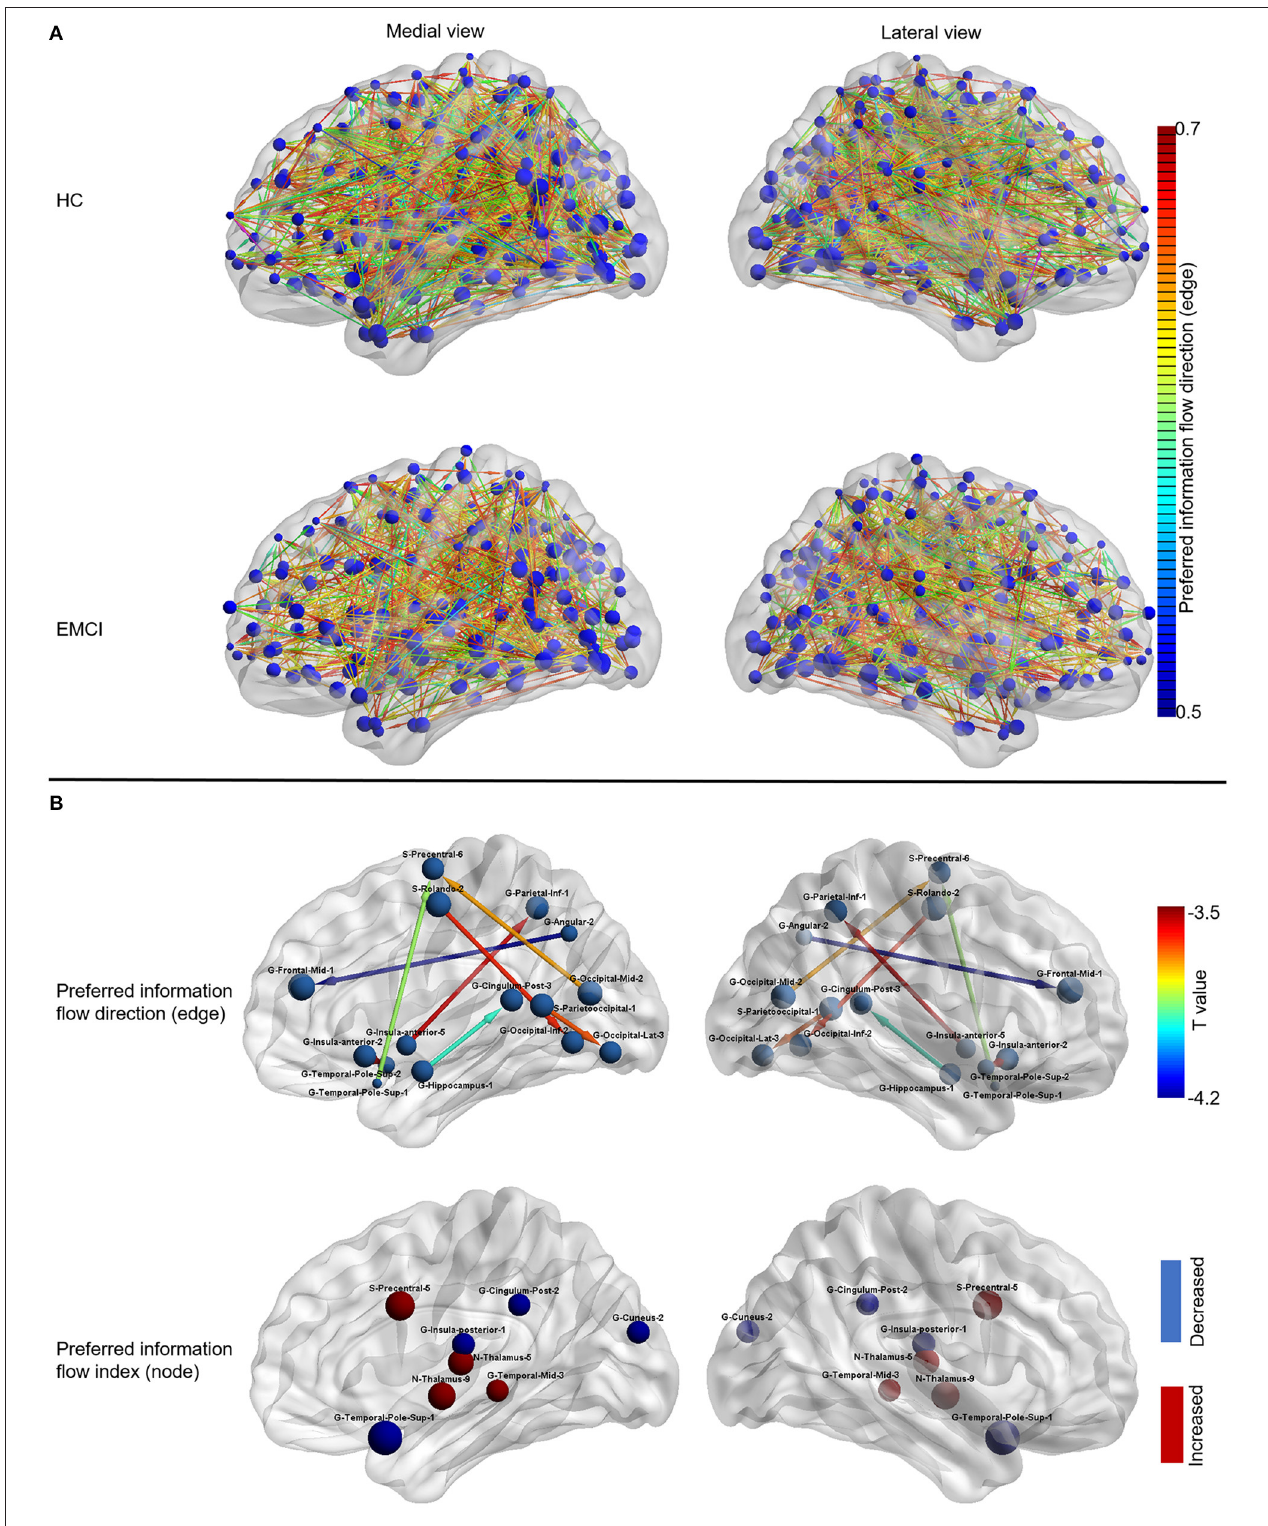
FIGURE 2 | The information flow patterns in HC and EMCI. (A) The preferred information flow direction and preferred information flow index in HC and EMCI. The node size indicated the value of the preferred information flow index. The color of the directed edge indicated the value of preferred information flow direction (only directed edges with values > 0.5 were presented); (B) The alterations of information flow patterns in EMCI compared to HC. The first row presented the edge-wise